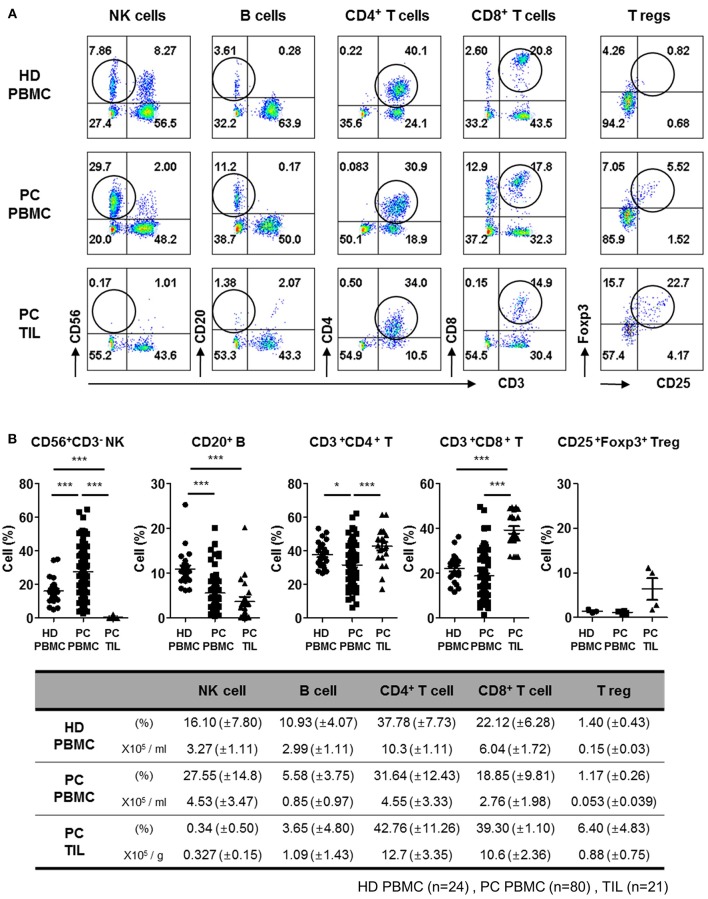
Flow cytometry analysis of tumor-infiltrating lymphocytes from patients with PDAC show lack of NK cell infiltration. (A) Representative flow cytometry data of lymphocyte frequency in PBMC of healthy donors, and PBMC and TIL of patients with PDAC are shown. Percentages of lymphocytes including NK, B, CD4+ T, CD8+ T, and Treg cells in TILs and PBMCs are written in each quadrangle of the graph. Treg cells were analyzed on CD3+CD4+ subset by intracellular Foxp3 staining. (B) The percentages of lymphocytes from individual patients are summarized as dot plots (Top) and a table showing mean ± SD (HD PBMC, n = 24; PDAC PBMC, n = 80; PDAC TIL, n = 21). The peripheral NK cell percentages of patients with respect to their NK cells infiltrated within TIL was marked in Red, in the Figure S4. Statistical differences between each group were calculated by Student's t-test (*p ≤ 0.05; ***p < 0.001).